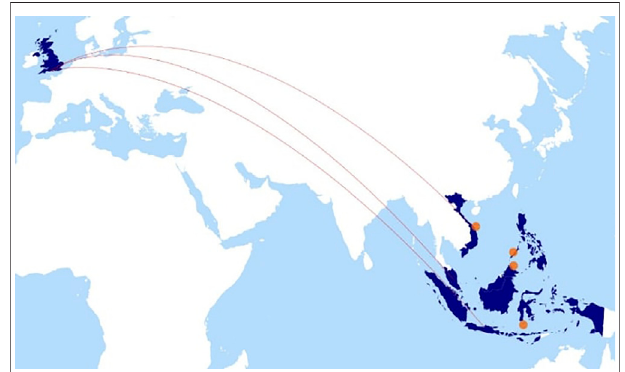
FIGURE 1 | The four countries (Indonesia, Malaysia, United Kingdom and Vietnam) participating in the virtual capacity-building workshop (as depicted with the red lines) on stakeholder interaction that will be carried out in the case study sites (Taka Bonerate Kepulauan Selayar Biosphere Reserve, Tun Mustafa Park, Cu Lao Cham and Palawan; as depicted with the orange bullets).